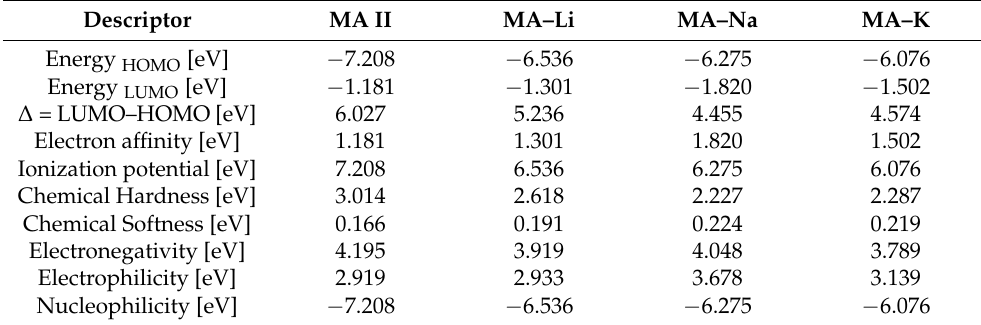
Table 6. Values of selected reactivity parameters (descriptors) calculated for ligand (MA) and salts/complexes with selected alkali metals.